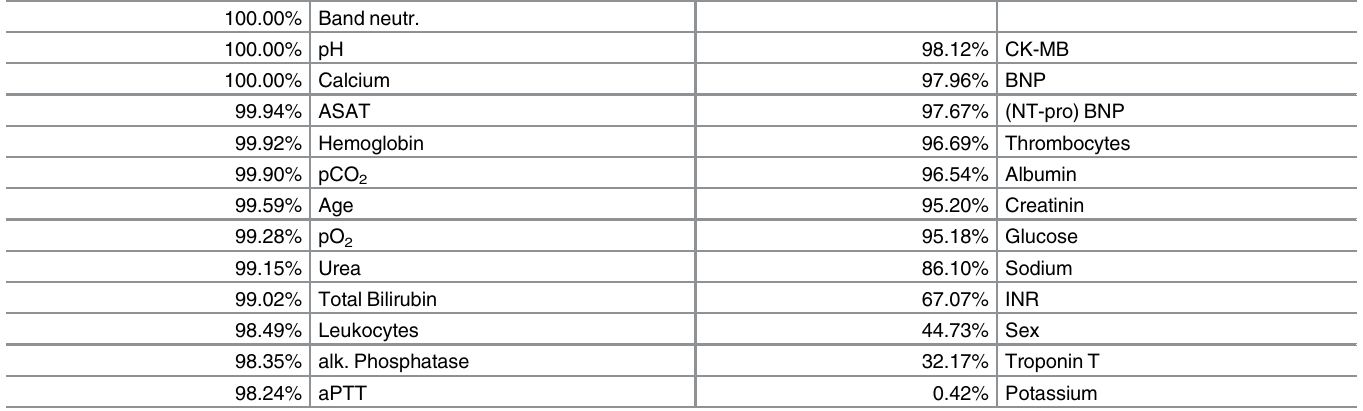
Table 3. Attribute importance (average of 11 decision trees; C5.0 algorithms used splits) for the imputed dataset. 100.00% Band